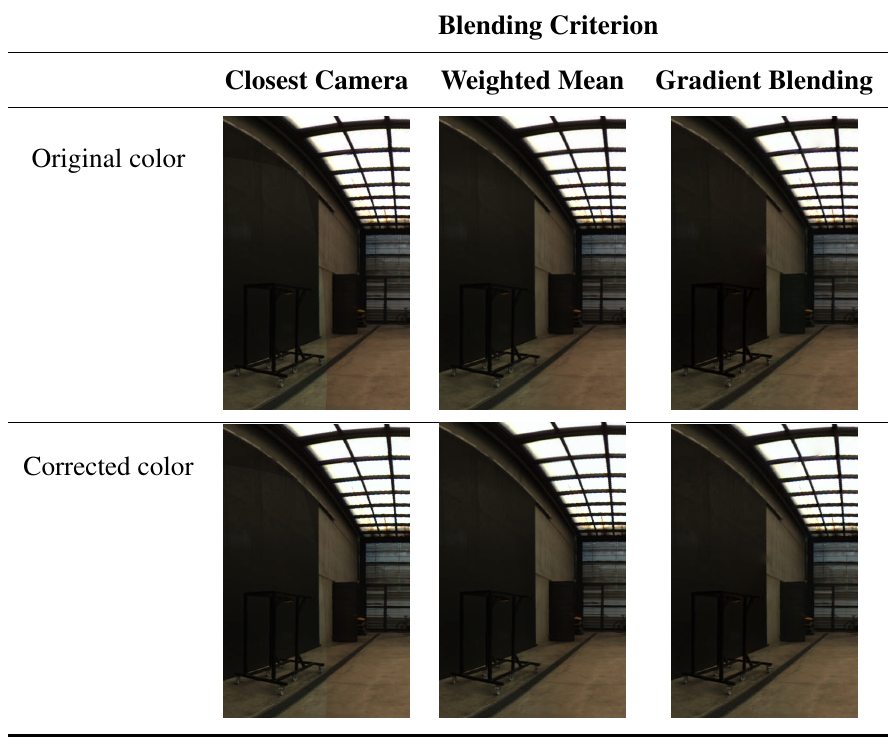
Table 1. Transition in a panorama with different blending criteria applied and without or with individual gain correction. The color transition is more homogeneous when applying gain corrections, and the transition is smoother when moving from left to right using the blending criterion